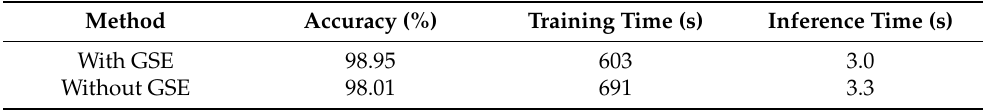
Table 2. The accuracy and time assessments of gesture skeleton extractor